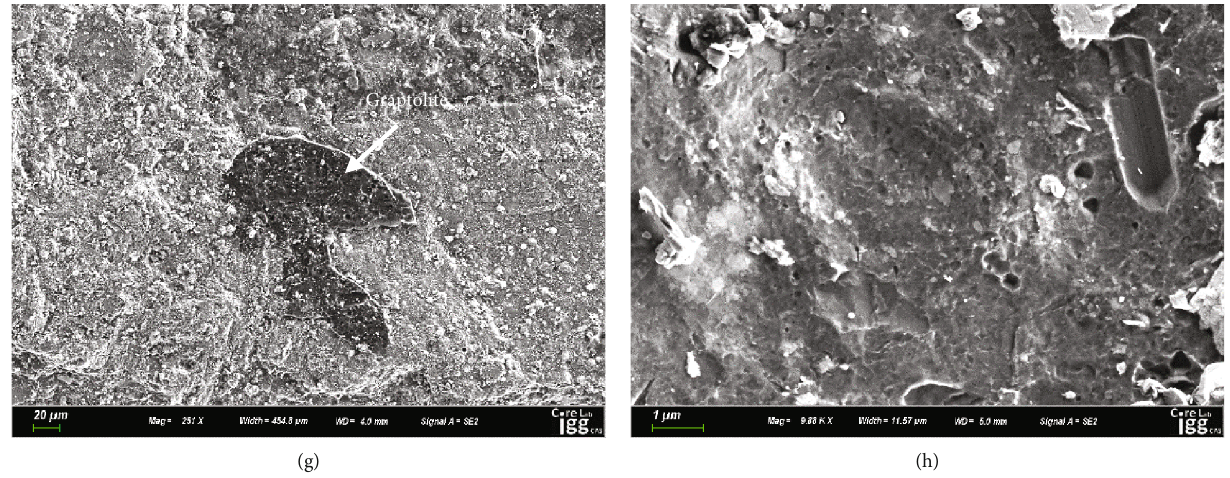
Figure 10: SEM images showing zooclast types and related pores in Wufeng-Longmaxi shale samples. (a – d) Zooclasts, including graptolite, chitinozoan, and acritarch, have no observable pores. (e, g) SEM images of graptolite in natural cores with no polishing. (f, h) Enlarged images of (e, g) in the arrow-pointed area,